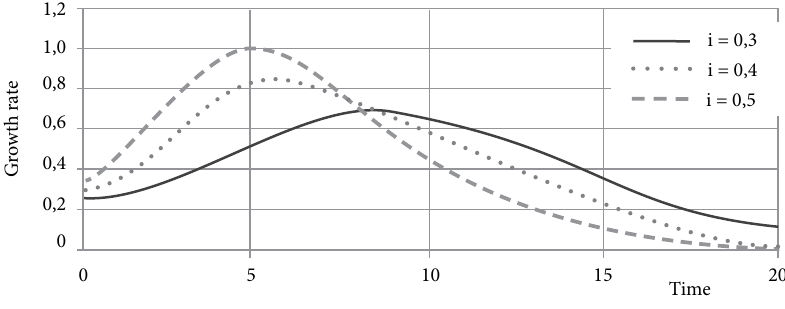
Fig. 3. Capital growth rate for different interest